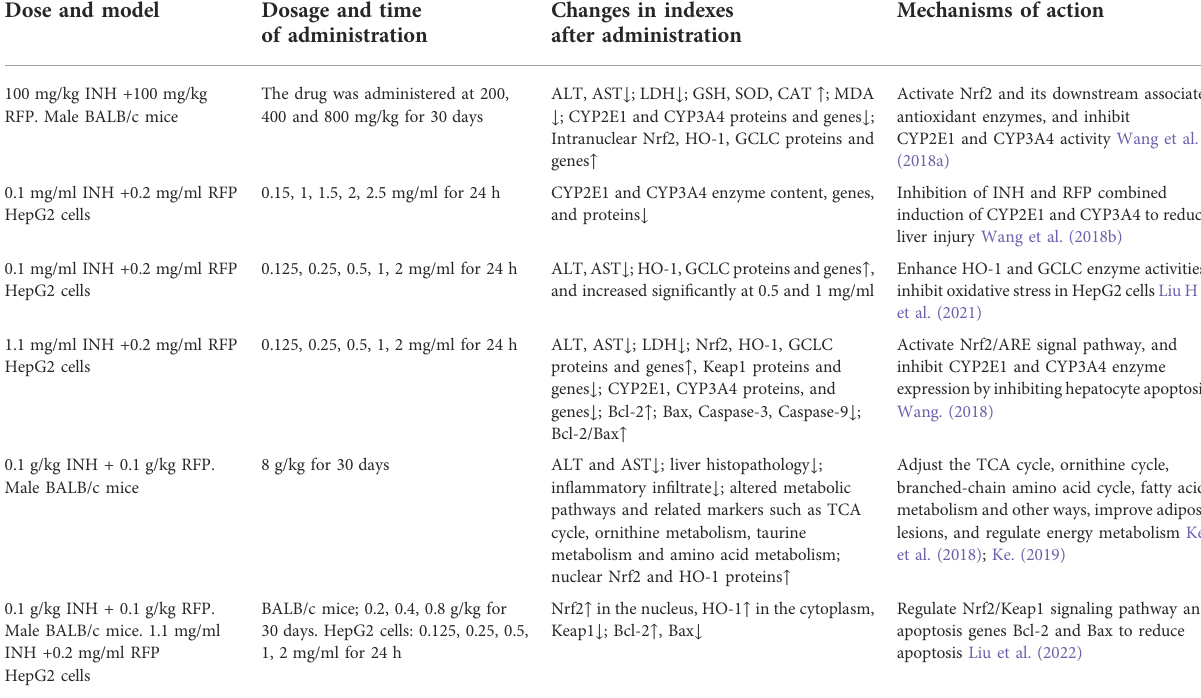
TABLE 2 The protective mechanisms of Sagittaria sagittifolia polysaccharide on INH and RFP-induced liver injury. Dose and model Dosage and time Changes in indexes Mechanisms of of administration after administration